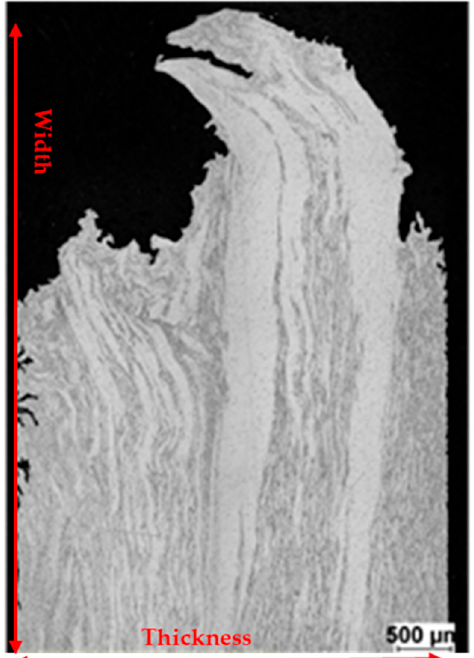
Figure 2. SEM images of the surface of a jagged bar.